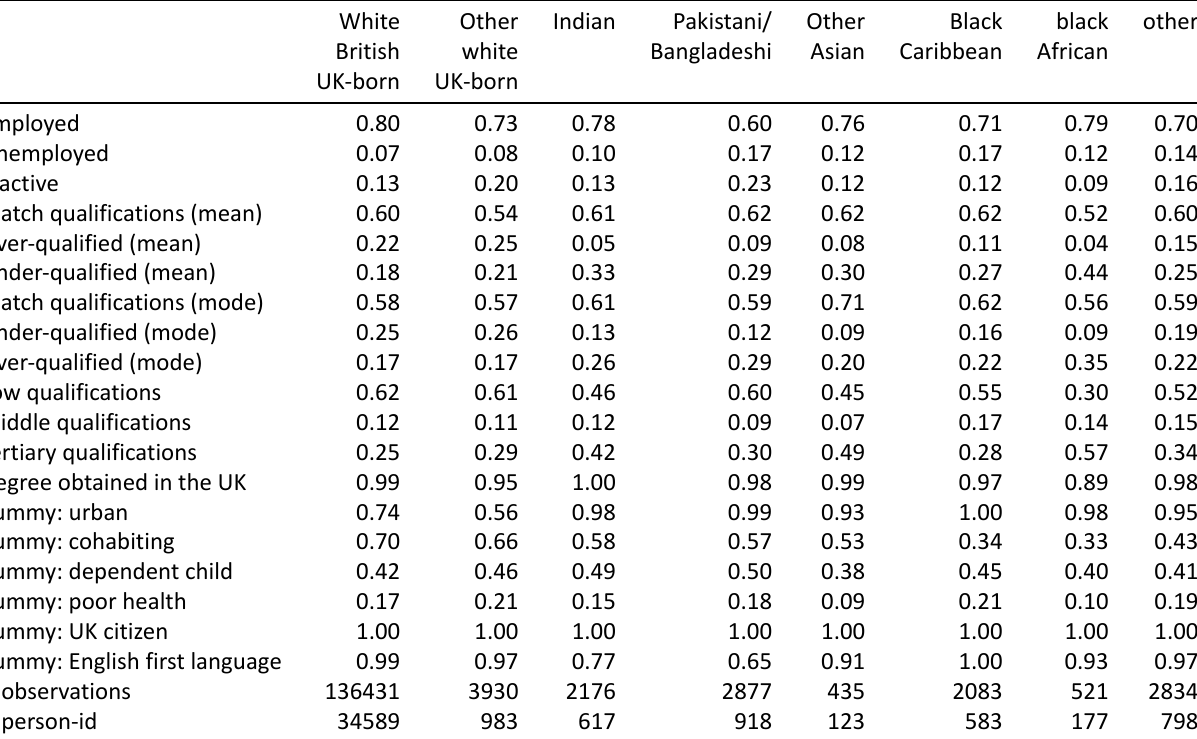
Table A1a. Descriptive statistics of sample for UK-born. White Other Indian Pakistani/ Other Black black other white Bangladeshi Asian Caribbean African